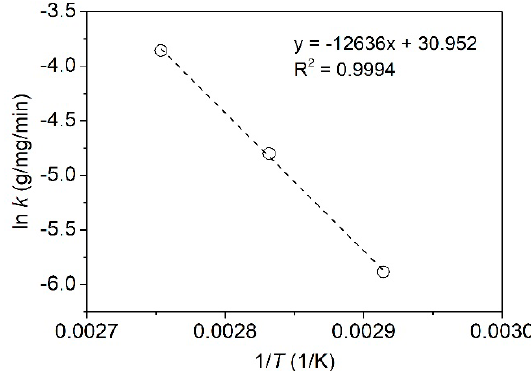
Figure 4. Plot of the Arrhenius equation at three temperatures.